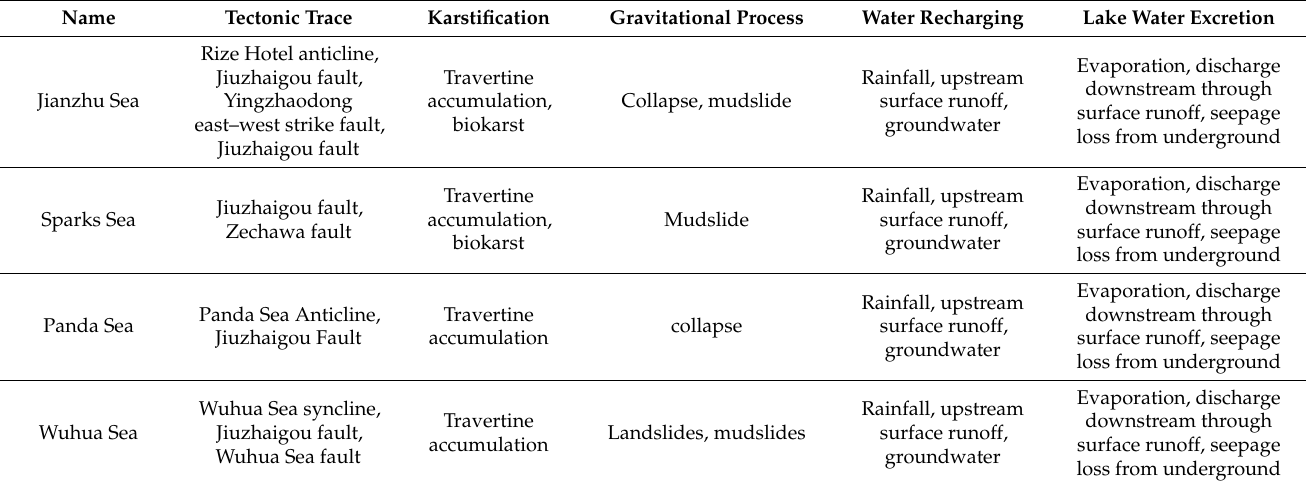
Table 3. Scenery analysis of damaged lakes in Jiuzhaigou.